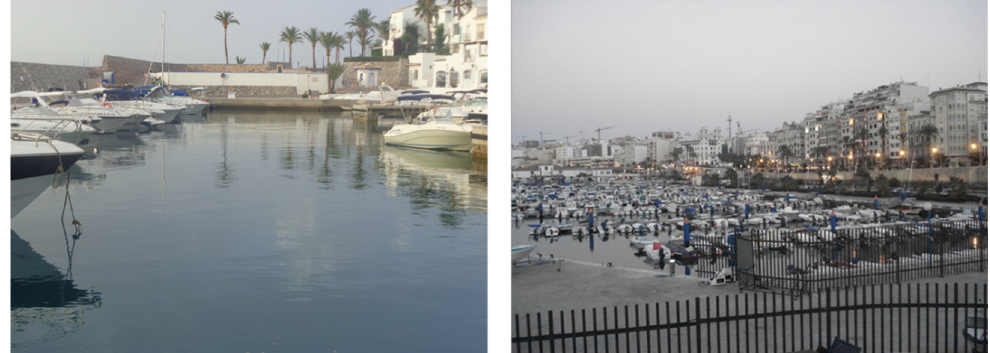
Figure 3. Figures 4–9 location map.